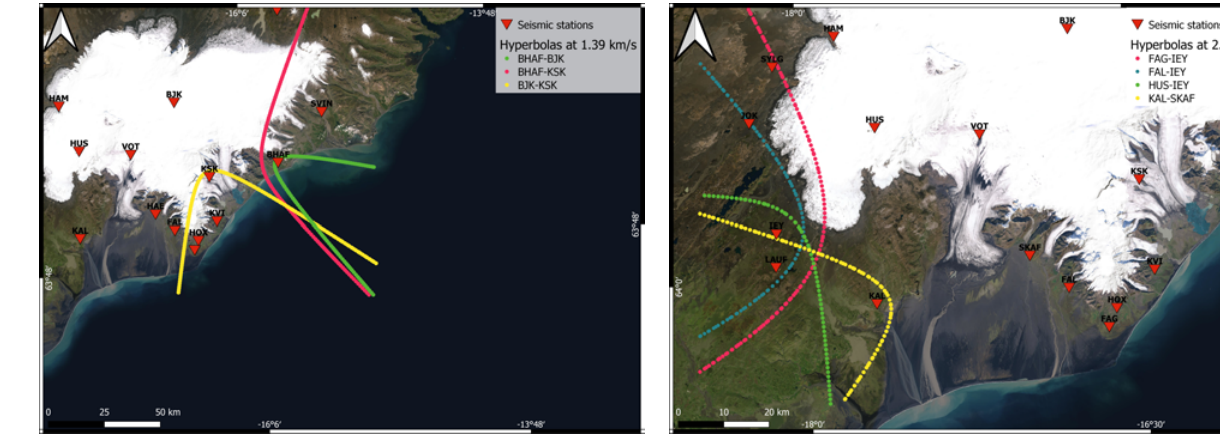
Figure 6: Map showing three hyperbolas for stations BHAF, BJK and KSK for a propagation velocity of 1.39 km s −1 . Lag times are: 36.65 s for BHAF-BJK, 12.2 s for BHAF-KSK, and ´ 22.65 s for BJK-KSK.